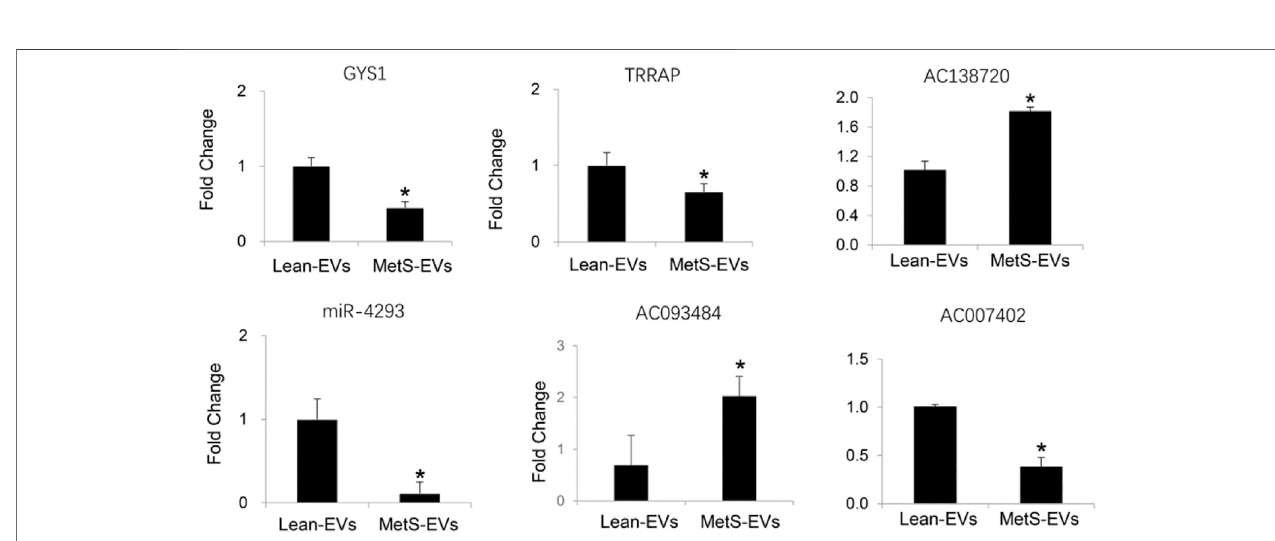
FIGURE 5 | qPCR showing the expression of candidate mRNAs, miRNAs, and lncRNAs following the same patterns as the RNA-Seq fi ndings (Student ’ s t -test). * p < 0.05 vs. Lean-EVs.